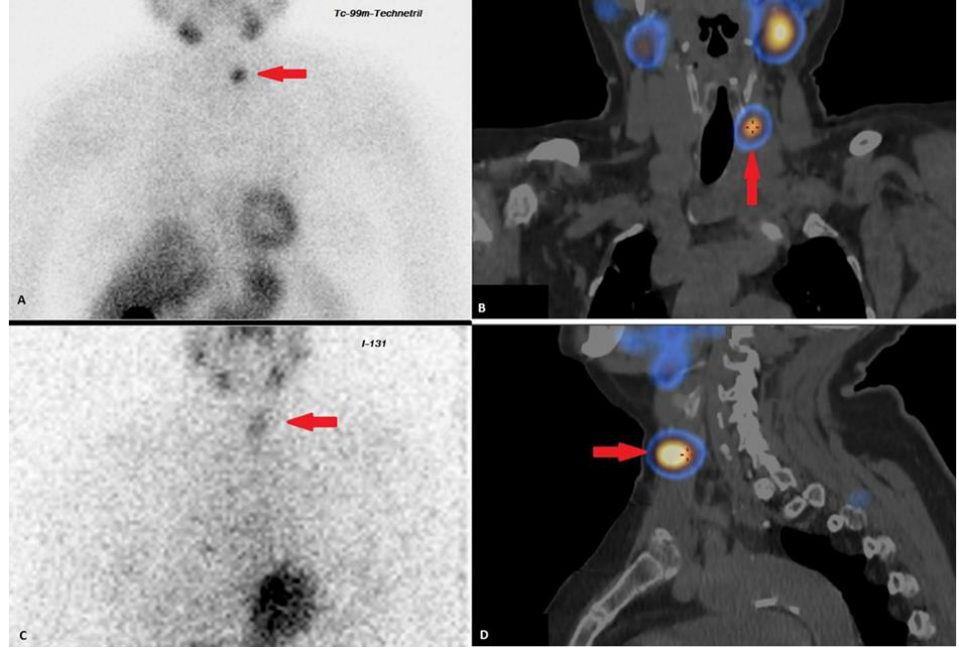
Figure 2. ( A ) planar scintigraphy with 99 mTc-MIBI ( ← ); ( B ) SPECT-CT frontal slice, high uptake of 99 mTc-MIBI ( ↑ ); ( C ) Planar whole-body scintigraphy with I-131, ( ← ) tissue accumulating 131I is visualized in the projection of the thyroid bed, on the left; ( D ) SPECT-CT sagittal slice, scanning was performed 90 min after the administration of 700Mbq of 99 mTc-MIBI, ( → ) lesion in the left thyroid bed with high uptake of 99 mTc-MIBI. A total parathyroidectomy and central lymph node dissection using intraoperative navigation methods (single-channel gamma detection probe, Gamma Probe 2, and fluo- rescence angiography with indocyanine green (ICG), on SPY3000 (Novadaq Technologies; Toronto, ON, Canada)) was performed in March 2019. During the surgery, the lesion in the thyroid bed on the left showing significant uptake of the isotope ( 99 mTc-MIBI) and ICG was exposed (Figure 3). The histological examination revealed a piece of adipose tissue measuring 30 × 25 × 20 mm with a whitish dense nodule measuring 15 mm in diameter. There were also small gray-pink lesions with a diameter of up to 5 mm near the nodule. Mi- croscopic examination showed a focus of parathyroid cancer in fatty tissue, and two lymph nodes with subtotal metastases of papillary thyroid cancer (Table 1). Foci of parathyroid cancer and papillary thyroid cancer were observed in surrounding skeletal muscles. The morphological features of the parathyroid cancer were similar to the histological picture of the parathyroid cancer removed in 2010 (Figure